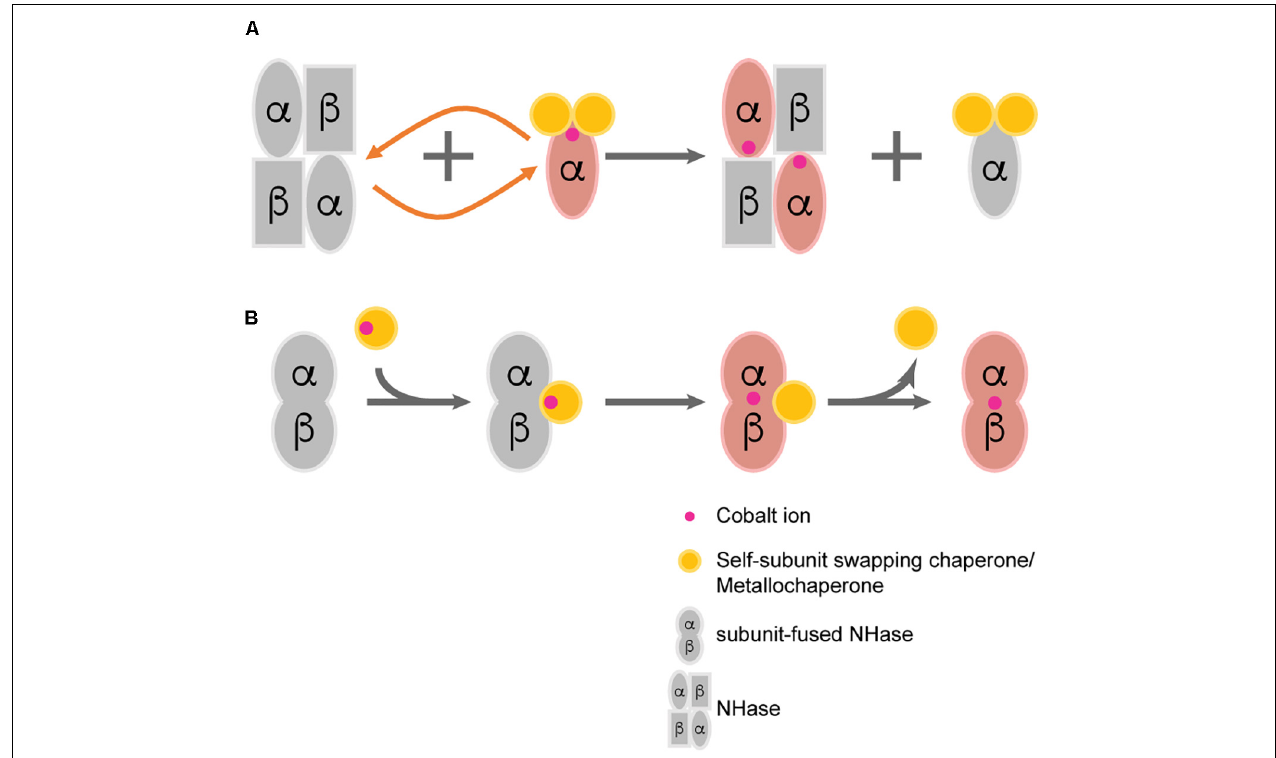
FIGURE 2 | Two proposed post-translational modification patterns of NHase. (A) Self-subunit swapping; (B) Direct metal ion incorporation regulated by metallochaperone.